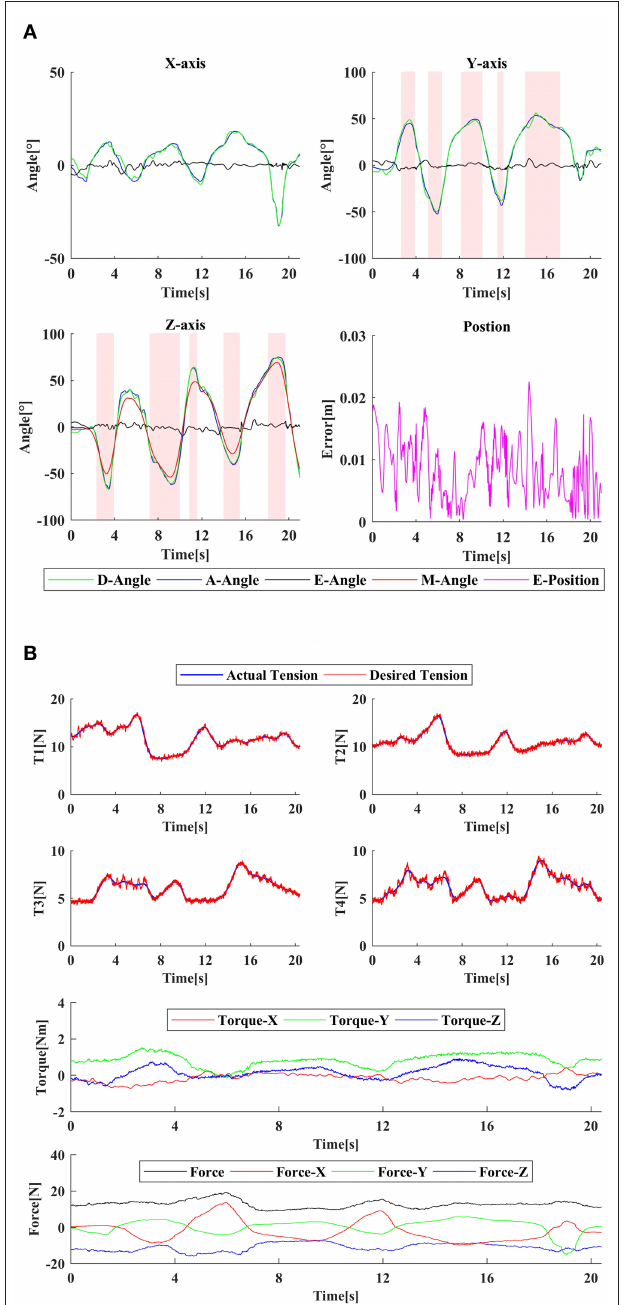
FIGURE 9 | The passive training experiment: (A) the tracking error, (B) the tension, parasitic force, and actual assistive torque curve. D/A/E/M-Angle represent the desired angle, the actual angle, the tracking error of the angle, and the angle of the Z-axis, respectively. E-Position means the tracking error of the position. The red area in (A) is the infeasible area of CDWRR.